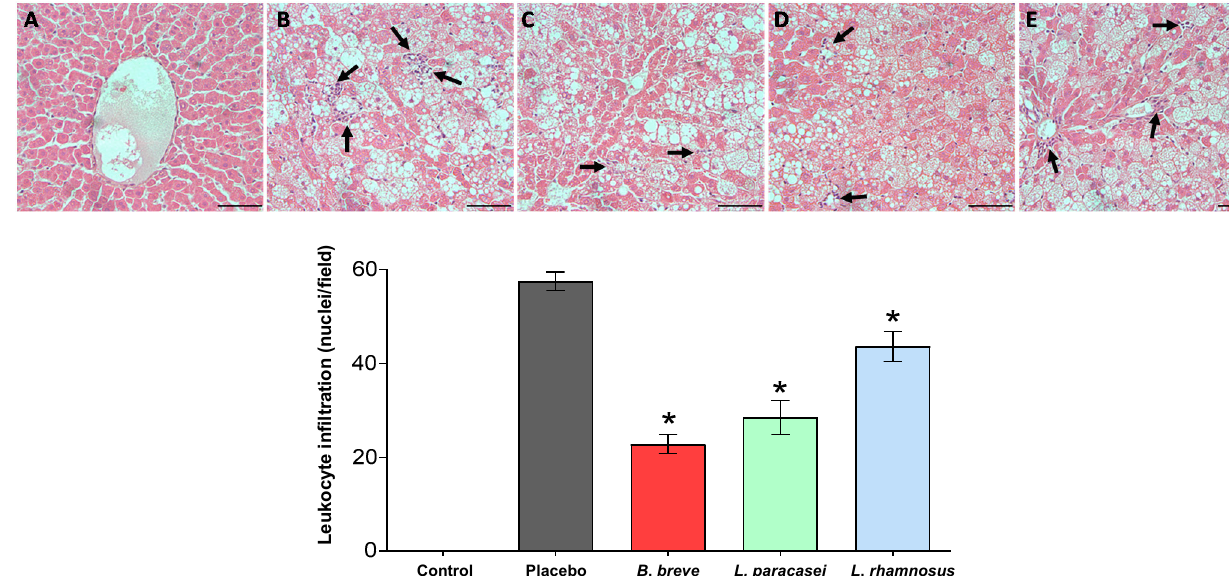
Figure 5. Inflammatory cell infiltration. Upper panels: Representative micrographs of 5- µ m-thick liver sections stained with hematoxylin and eosin (H&E) of ( A ) control group, ( B ) placebo group, ( C ) B. breve group, ( D ) L. paracasei group, and ( E ) L. rhamnosus group. Bars = 20 µ m. Lower panel: Quantification corresponding to the stained sections. Values are the means ± SEM, n = 3–4 per group. * p < 0.05 vs. placebo. B, Bifidobacterium; L, Lactobacillus.